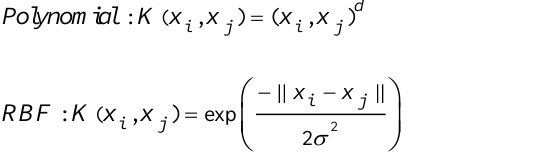
Equations 6 and 7 represent the Gaussian and polynomial types